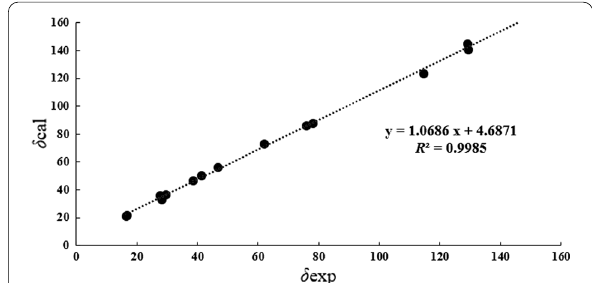
Fig. 6 Linear correlation between the experimental and calculated 13 C NMR chemical shifts for 3